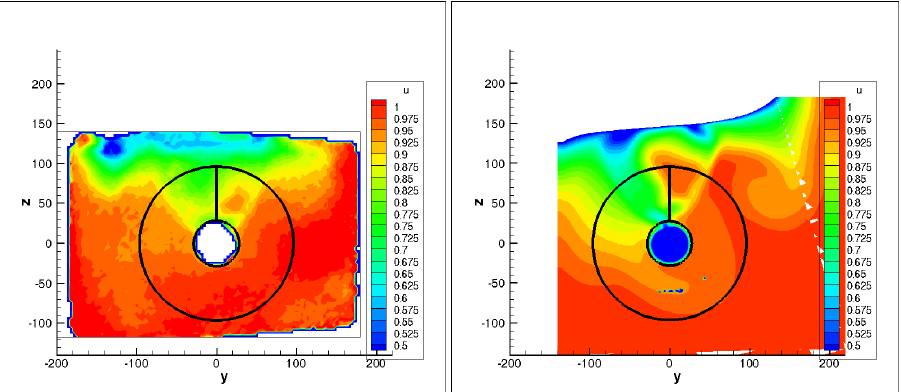
Figure 4. Nominal wake of the model hull in straight-ahead motion: axial velocity component at the starboard side close to the propeller shaft end (position in mm). ( Left ) stereo-PIV measurements. ( Right ) RANS